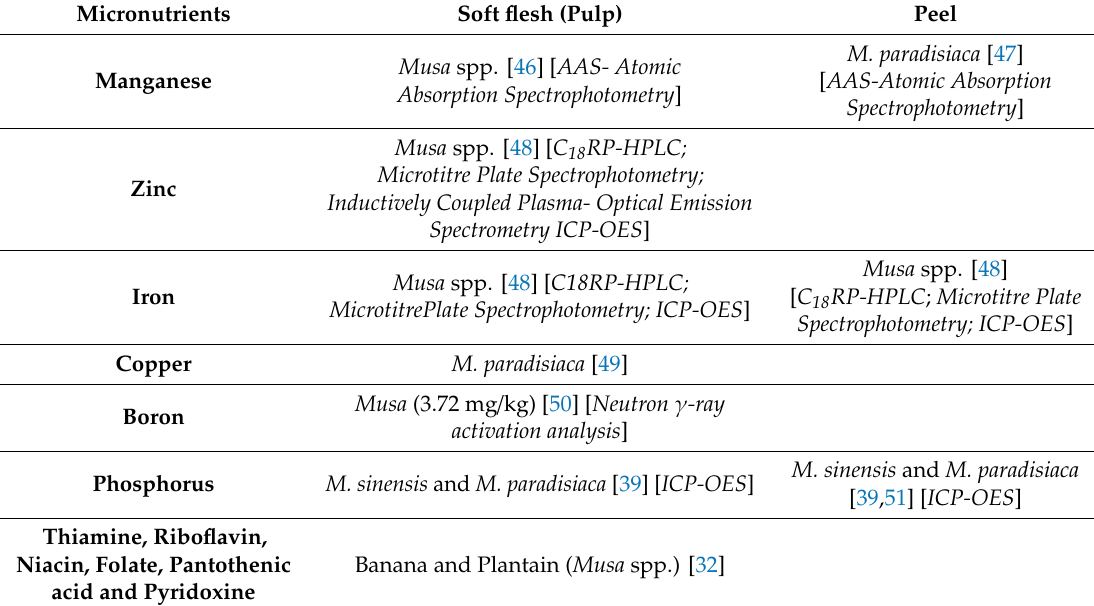
Table 2. Micronutritional factors identified in fruit compartments of Musa species fruits including the analytical